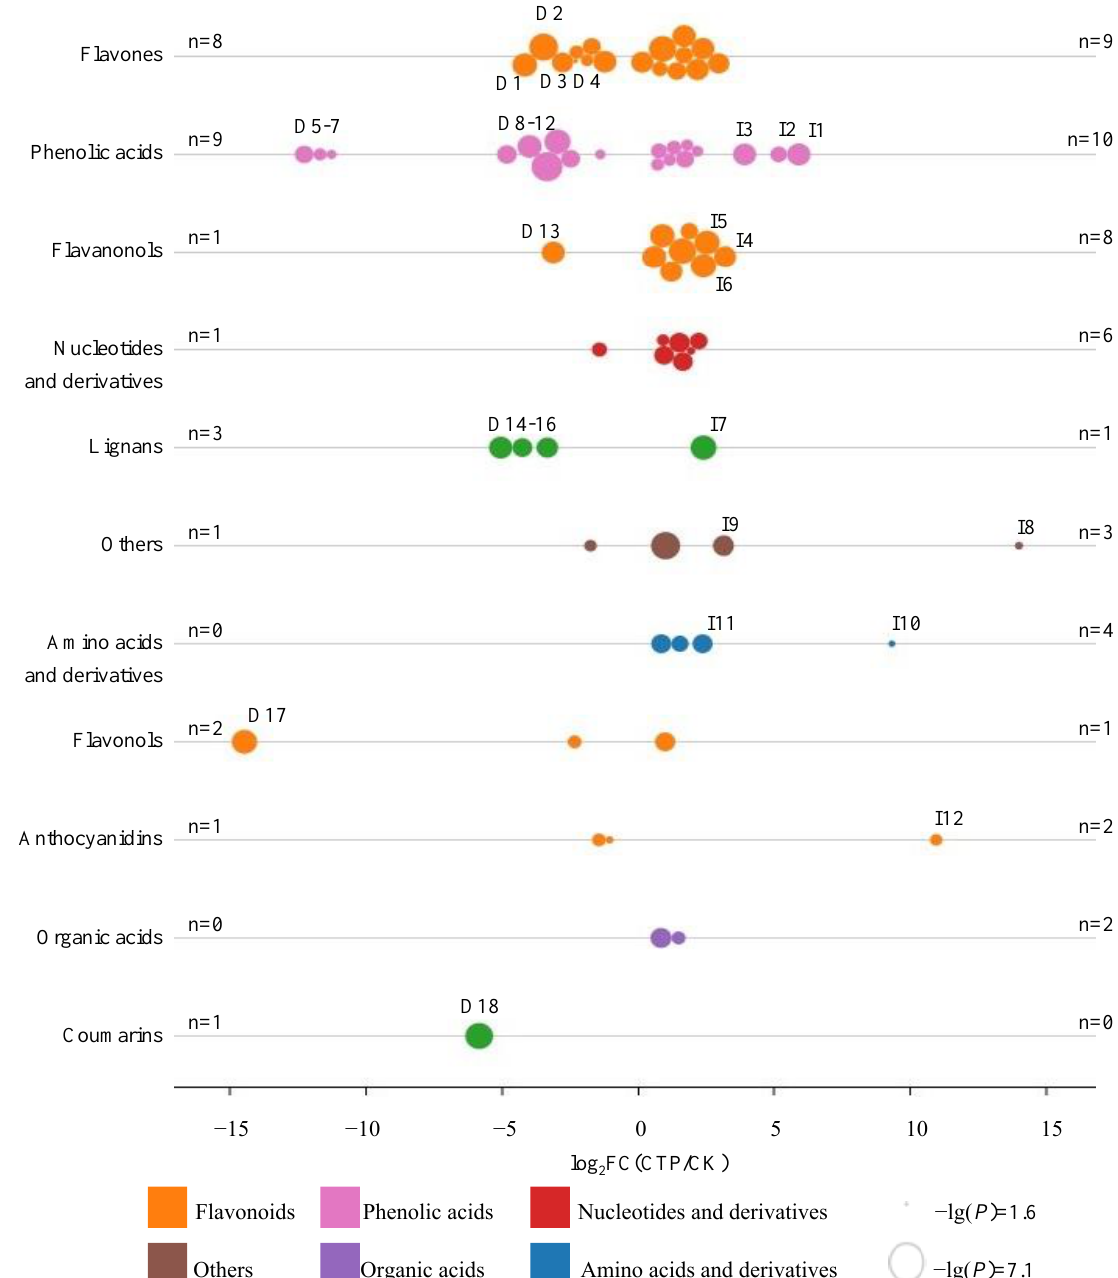
(e.g., EC and ECG) and trihydroxy-B-cycloflavanol (e.g., EGC and EGCG) through the structural formula and the change of the levels of metabolites (Figure 5).